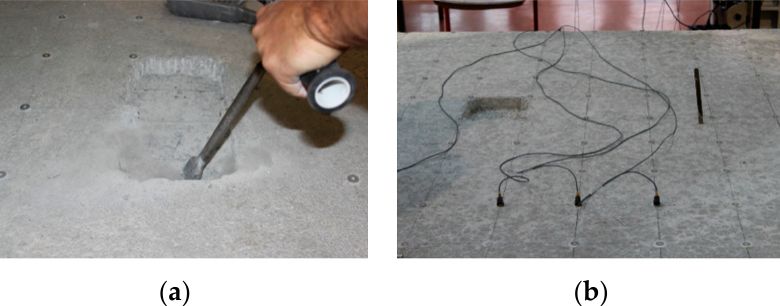
Figure 4. Discrete damages on the RC plate: ( a ) chiseling; ( b ) one of the damage locations on the concrete plate.